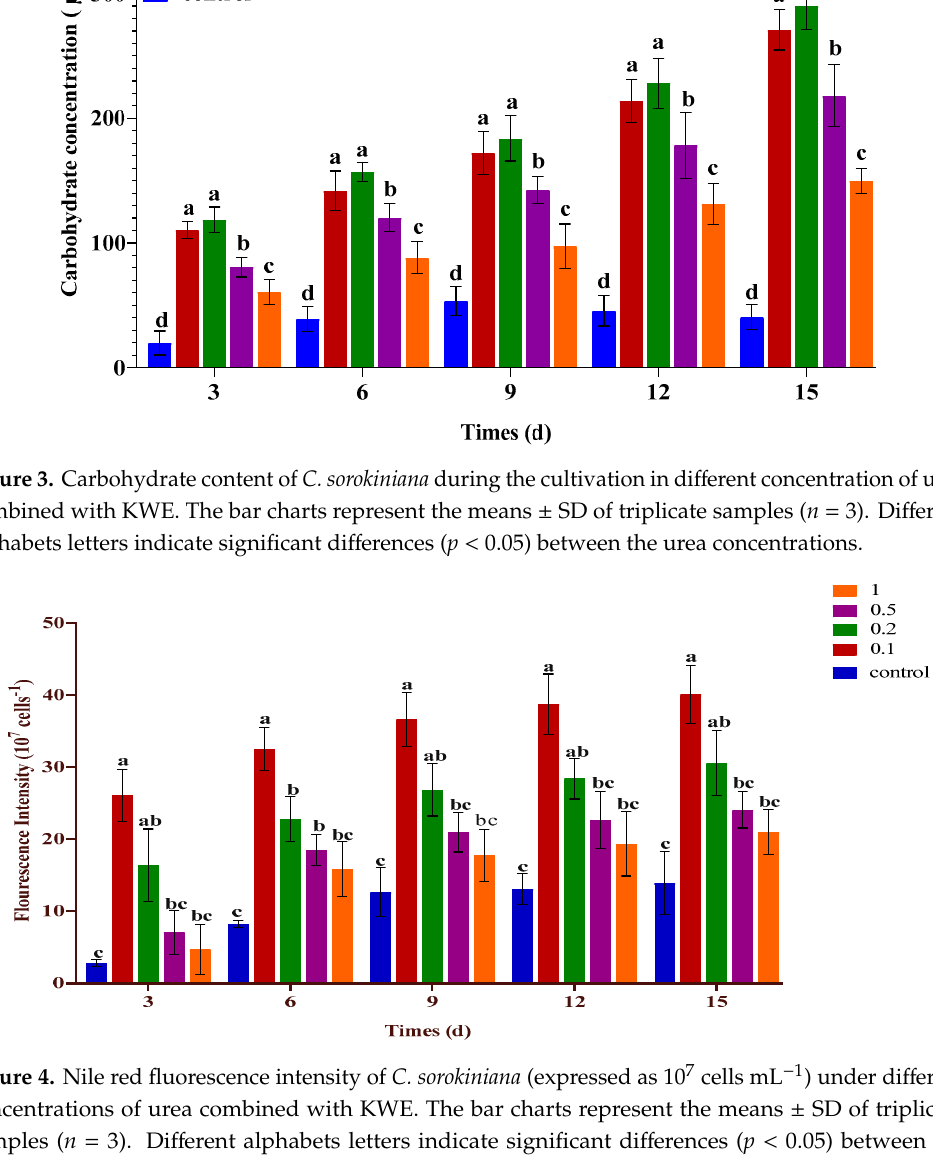
Figure 3. Carbohydrate content of C. sorokiniana during the cultivation in different concentration of urea combined with KWE. The bar charts represent the means ± SD of triplicate samples ( n = 3). Different alphabets letters indicate significant differences ( p < 0.05) between the urea concentrations.